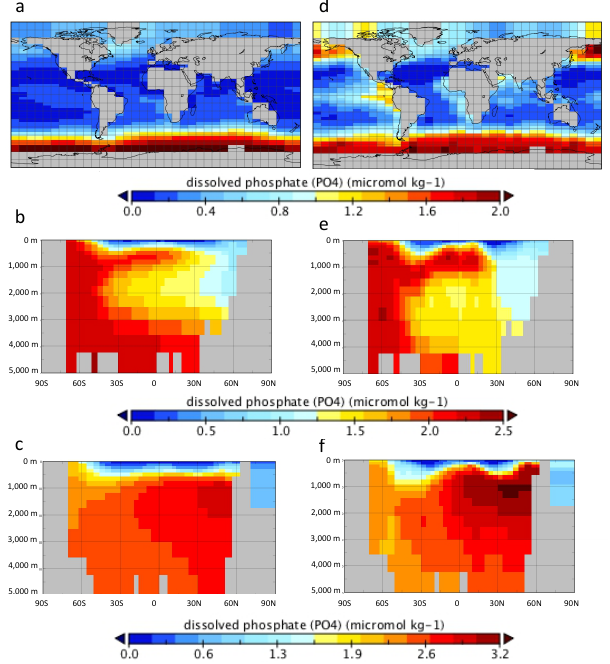
Fig. 6. Dissolved oxygen: (a) , (b) and (c) EFPC ensemble averages, (d) , (e) and (f) observations (Garcia et al., 2006). Upper panels are surface fields ( ∼ 81m depth). Middle panels are Atlantic cross sec- tions (25 ◦ W). Lower panels are Pacific cross sections (155 ◦